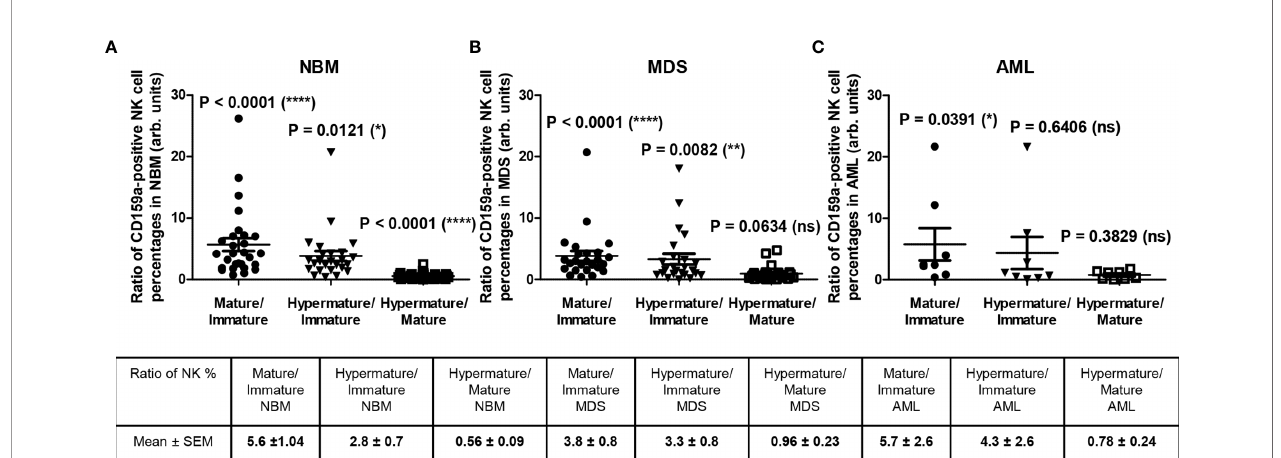
FIGURE 6 | Ratio of cell percentages in distinct CD159a-positive NK maturation subsets within the bone marrow microenvironment of NBM, MDS, and AML cases. (A) Ratio of cell percentages for the indicated CD159a-positive NK maturation subsets (mature to immature, hypermature to immature, and hypermature to mature) in normal bone marrow (NBM, n = 30) cases. Data are presented as scatter dot plots, and the lines represent the mean ± SEM (****P < 0.0001, *P < 0.05, ns, not signi fi cant; Wilcoxon signed rank test). (B) Ratio of cell percentages for the indicated NK maturation subsets (mature to immature, hypermature to immature, and hypermature to mature) in myelodysplastic syndromes (MDS, n = 25) cases. Data are presented as scatter dot plots, and the lines represent the mean ± SEM (****P < 0.0001, **P < 0.01, ns, not signi fi cant; Wilcoxon signed rank test). (C) Ratio of cell percentages for the indicated NK maturation subsets (mature to immature, hypermature to immature, and hypermature to mature) in acute myeloid leukemia (AML, n = 8) cases. Data are presented as scatter dot plots, and the lines represent the mean ± SEM (*P < 0.05, ns, not signi fi cant; Wilcoxon signed rank